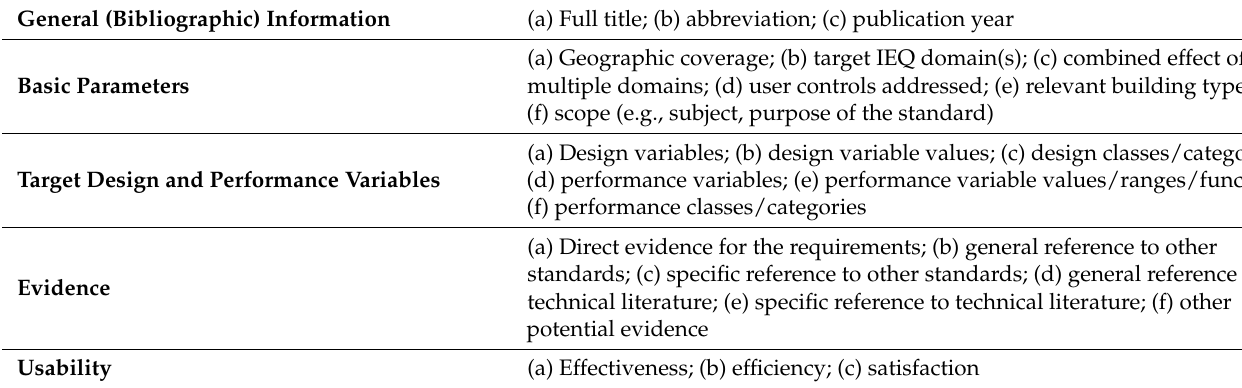
Table 1. Overview of the standard assessment matrix